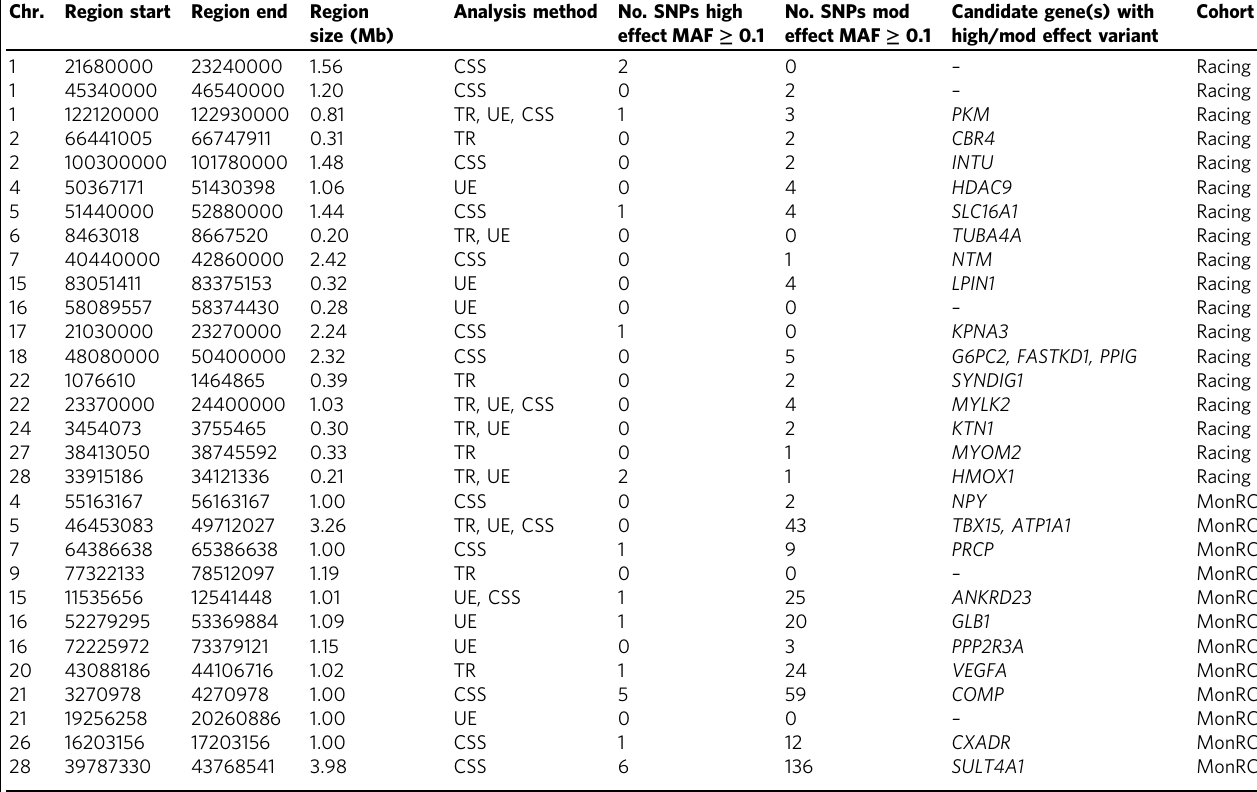
Table 3 Genomic regions chosen to search for high and moderate effect variants in the whole genome sequence data. Chr. Region start Region end Region size